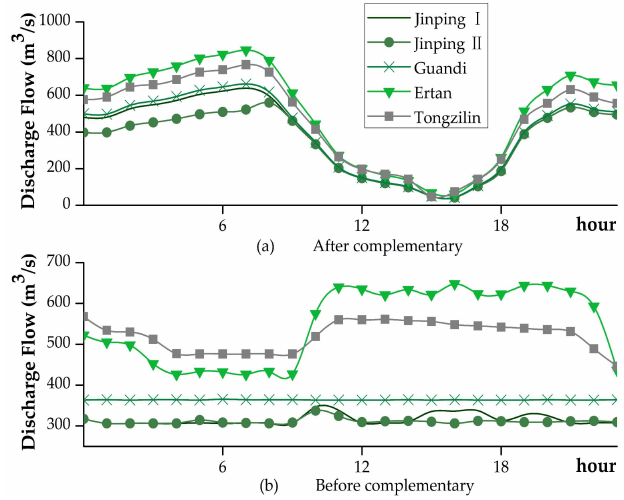
Figure 11. Discharge flow processes of S-SP before, and after, complementary optimization.